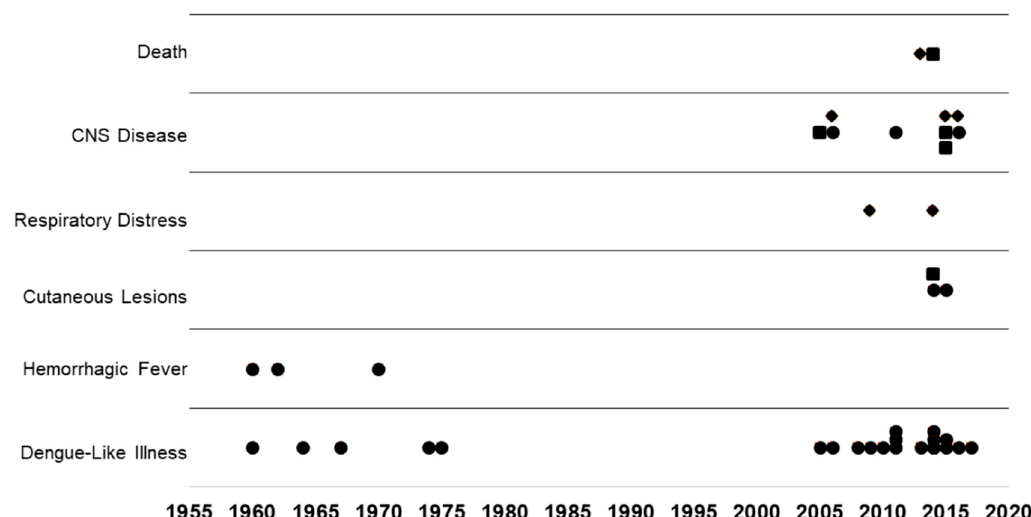
Figure 1. Consequences of congenital, perinatal, and pediatric chikungunya infections are increasing. Chikungunya infection in newborns, infants, and children documented since 1960 are plotted against the most severe symptoms or sequelae identified in the associated report.